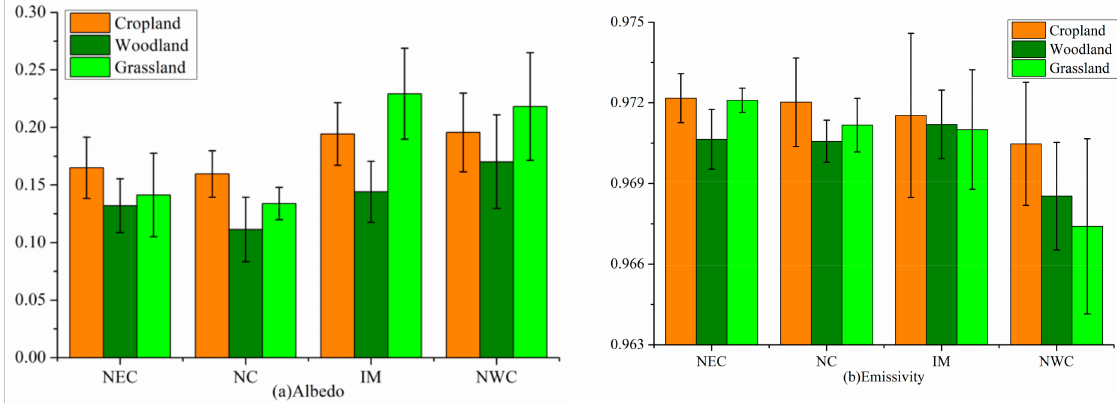
Figure 5. Average albedo ( a ) and emissivity ( b ) of each land use class in different zones.